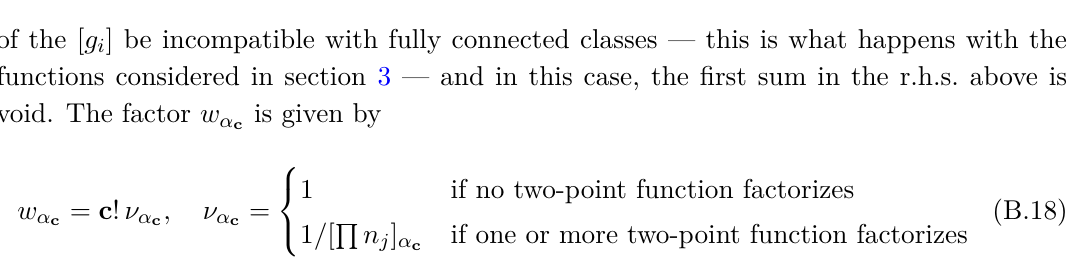
Figure 5 . Four different representatives of class α 2 representatives have the same active copies 1, 2, 3, 4, 5 appearing in different orders, but preserving the relative positions of repeated